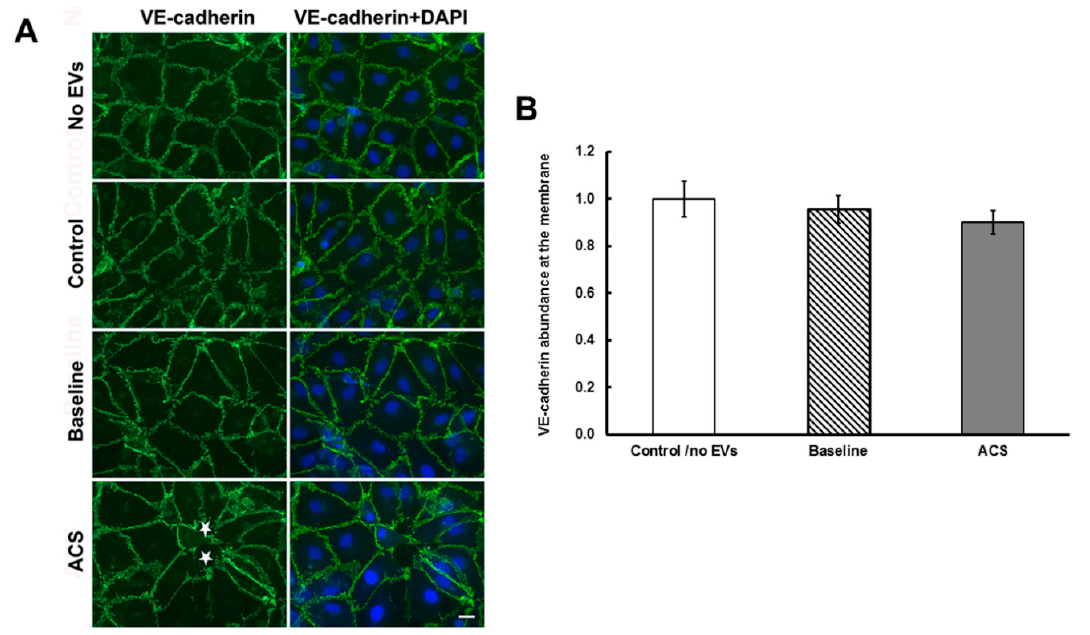
Figure 4. Localization of VE-cadherin and nuclei in endothelial cells treated with EVs. ( A ) Representative photomicrographs are shown for HMVEC-D cells 48 h after treatment with no EVs, EVs from a control subject, EVs from a subject with SCD at baseline, and EVs from the same subject at the beginning of an episode of ACS. VE-cadherin was detected by immunofluorescence (green) and nuclei by staining with DAPI (blue). In the example shown in the bottom row for an ACS sample, the monolayer disruption was 1.4%. White stars indicate spaces between cells. Scale bar is 20 µm. ( B ) The extent of VE-cadherin at the membrane (normalized integrated intensity) was calculated using Image J software. No significant differences were found (using the same approach as for the analysis in Figure 3). Control/no EVs n = 3; baseline and ACS n = 5.